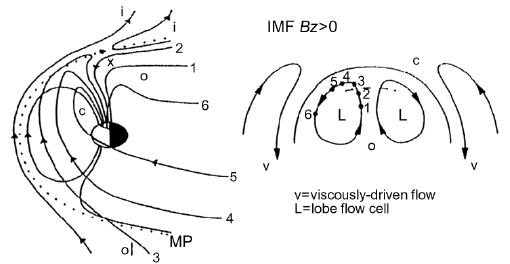
Fig. 15. Magnetic reconnection in the magnetos- pheric lobe and the consequent convection of plasma in the high-latitude ionosphere, which polewards of the adiaroic boundary is initially in a sunward direc- tion. From Lockwood (1998), reproduced by permis- sion of the